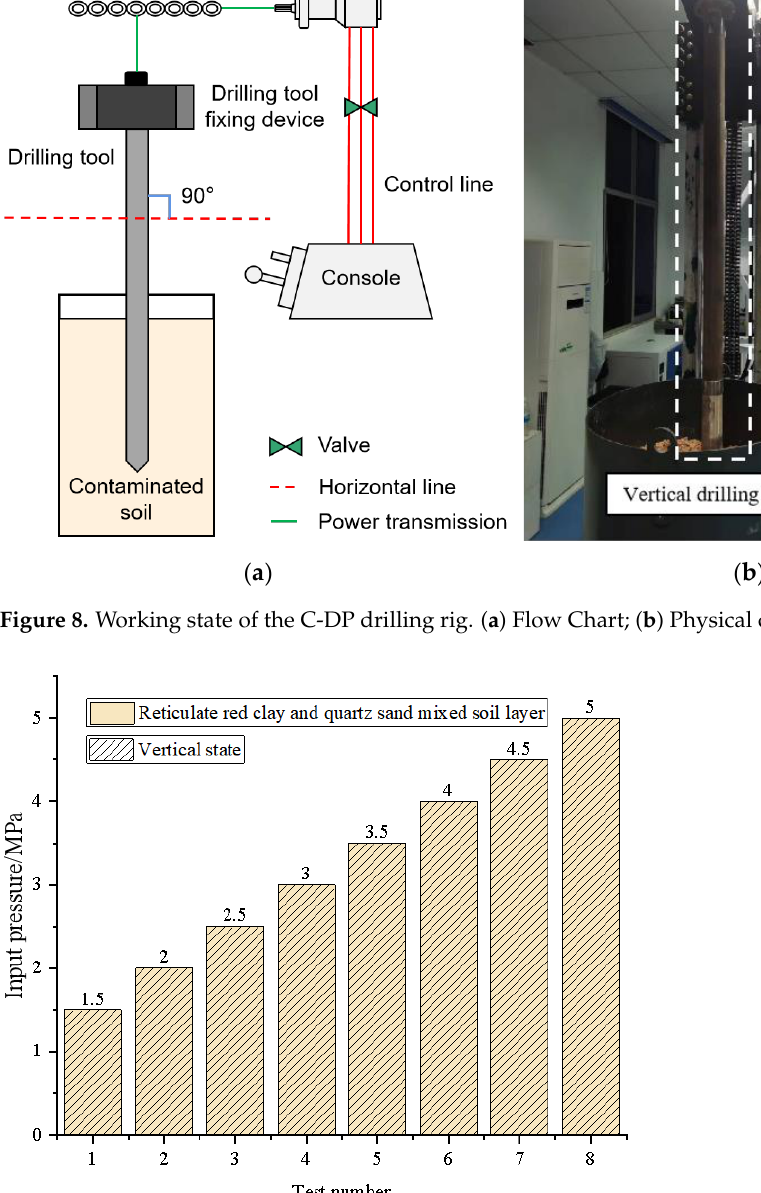
Figure 9. Test scheme.